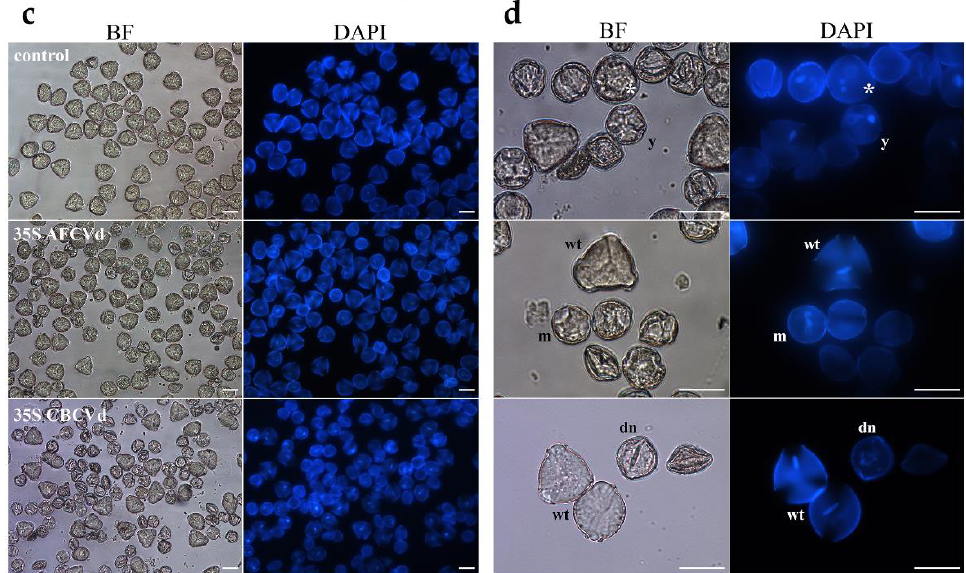
Figure 6. Microscopic analysis of mature pollen of control, 35S:AFCVd and 35S:CBCVd transformed N. benthamiana . ( a ) Quantification of the most common pollen phenotypes (in percent, mean ± S.D., n ≥ 9); healthy looking mature pollen grains (wt), aborted pollen (aborted) and young immature pollen grains (young). Lines with asterisks (* p < 0.05) indicate statistically significant differences between connected values. ( b ) Microscopic images of wt, aborted (ab) and young (y) pollen grains quantified in graph. ( c ) Overall microscopic views of mature pollen of the relevant variant. ( d ) Microscopic images of trinuclear pollen grain (asterisk), pollen with malformed nucleus (m) and pollen with partially degraded nucleus (dn) found in mature pollen of 35S:CBCVd transformed plants. (BF) bright field, (DAPI) fluorescence after DAPI staining and scale 30 µm in all microscopic images.